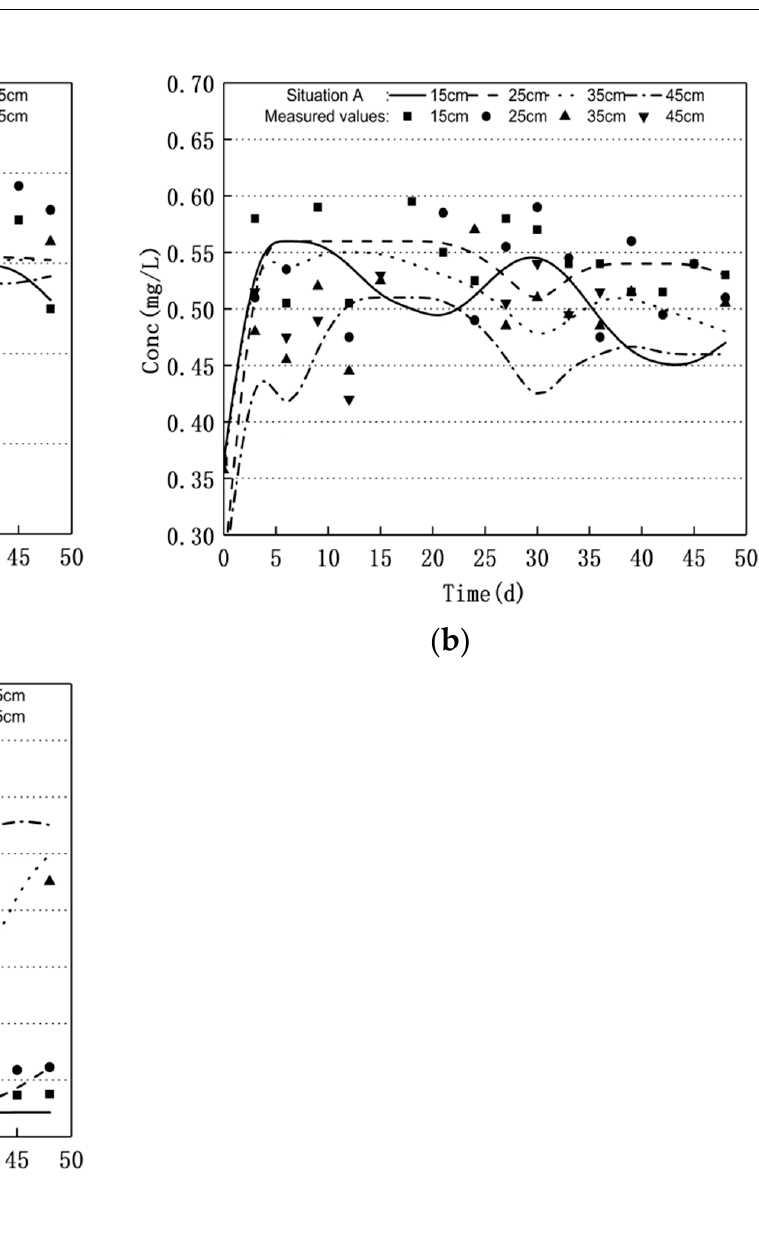
Figure 8. The measured results of coarse sand and the process of dynamic change of nitrogen in